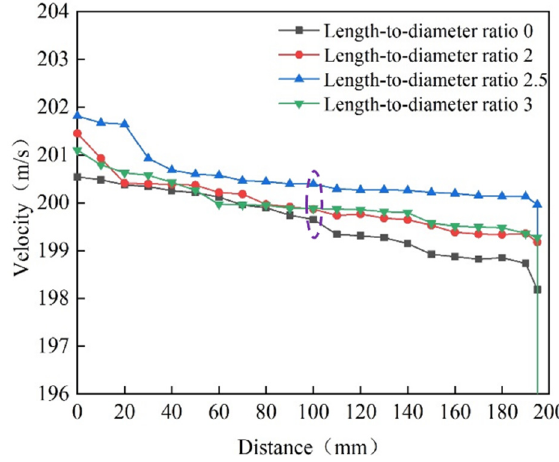
Figure 8. Effect of length-to-diameter ratio on X-axis velocity attenuation of water jet. The non-zero value of the length-to-diameter ratio will increase the effective Y-axis extension distance of the water jet. When the length-to-diameter ratio is l / d = 2.5, the effective Y-axis extension distance is the maximum, which is increased by 8.3% compared with the minimum value, as shown in Figure 9. Note that the non-zero value of length-to-diameter increases the effective area of the water jet and improves the effects of coal breaking and punching.